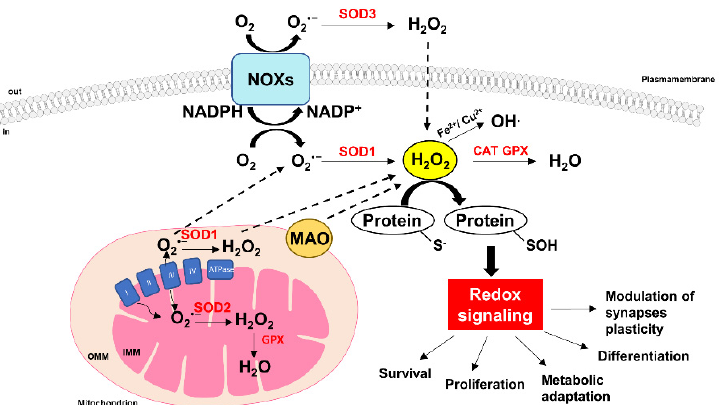
Figure 1. ROS-mediated cellular signaling. ROS are highly reactive molecules that can act as second messengers by triggering a variety of cellular signaling pathways with a crucial impact on cell phys- iology, metabolism and survival. The mitochondrial electron transport chain (ETC) and NADPH oxidase complex take up O 2 and generate O 2• − , which is dismutated to H 2 O 2 by superoxide dis- mutase (SOD) enzymes. Monoamine oxidases (MAOs) are flavoenzyme oxidases that produce H 2 O 2 by using O 2 as an electron acceptor molecule. H 2 O 2 is converted to H 2 O by catalase (CAT) and glu- tathione peroxidase (GPX). In the presence of Fe or Cu ions, H 2 O 2 converts to hydroxyl radical ( • OH) through Fenton’s reaction.